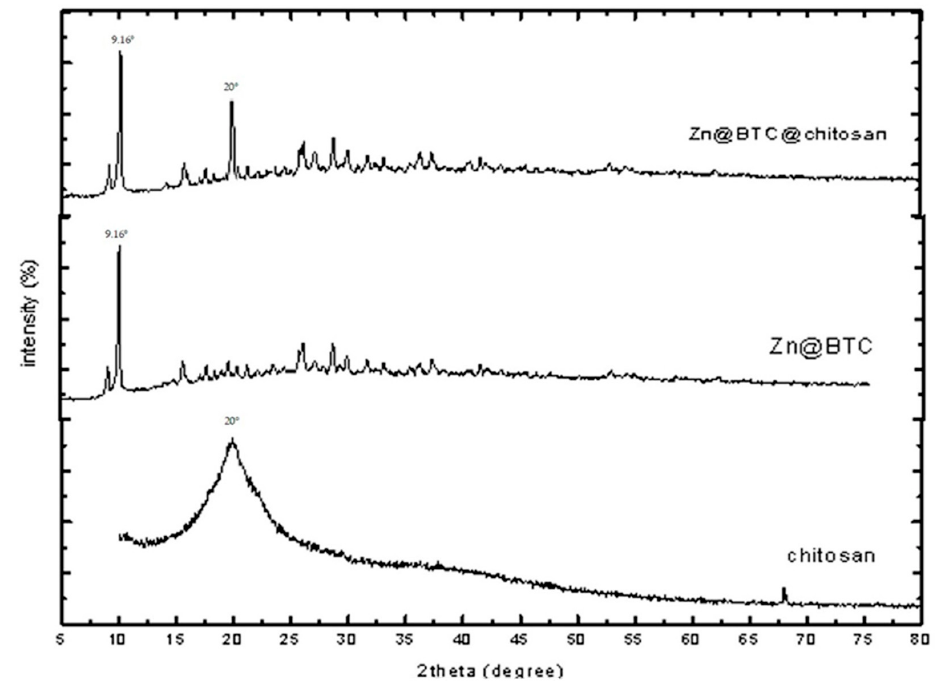
Figure 2. XRD patterns of chitosan, Zn-BTC, and Zn-BTC@CS.